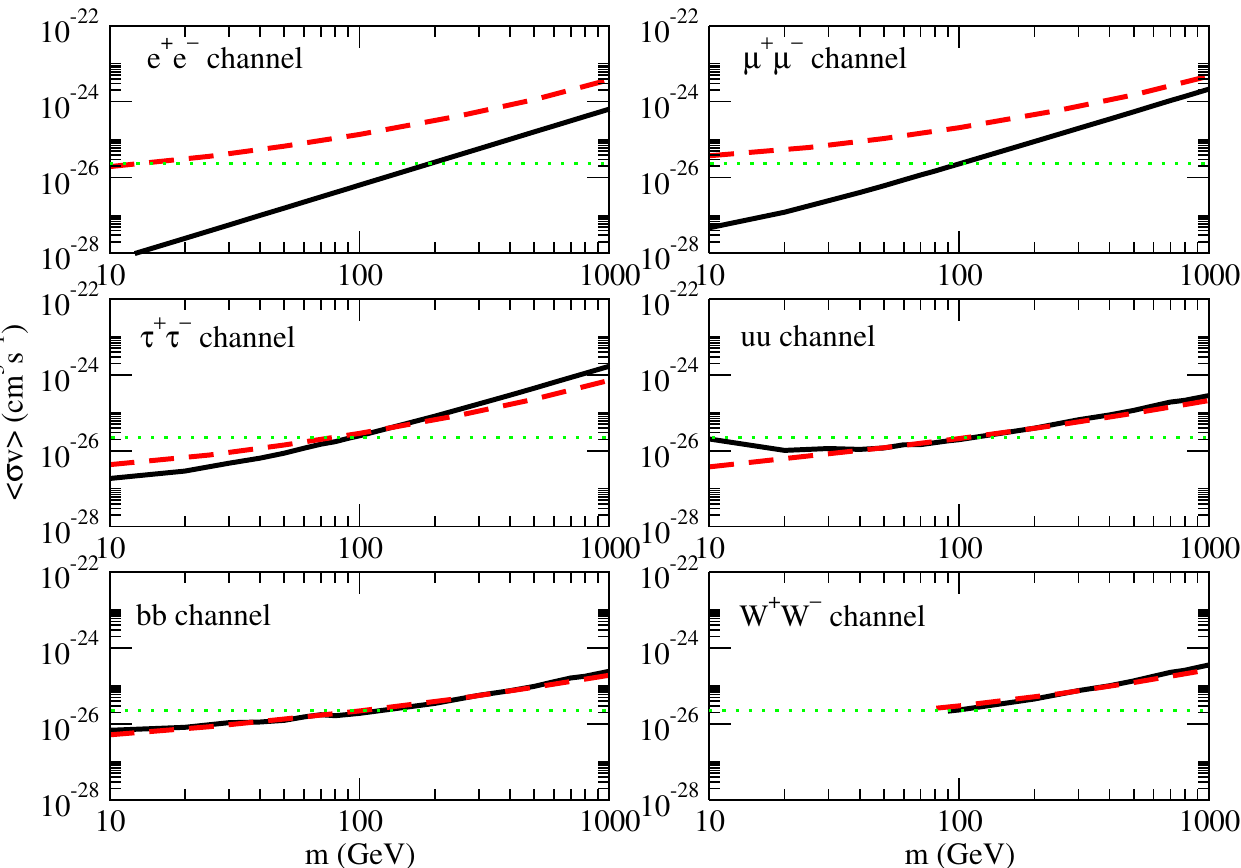
Figure 1. The black solid lines represent the upper limits of the annihilation cross-sections for six popular annihilation channels based on our previous radio analysis [28]. The red dashed lines are the corresponding upper limits based on the gamma-ray analysis of the Milky Way dwarf spheroidal galaxies [3]. The green dotted lines indicate the thermal relic annihilation cross-section (cid:104) σ v (cid:105) = 2.2 × 10 − 26 cm 3 s − 1